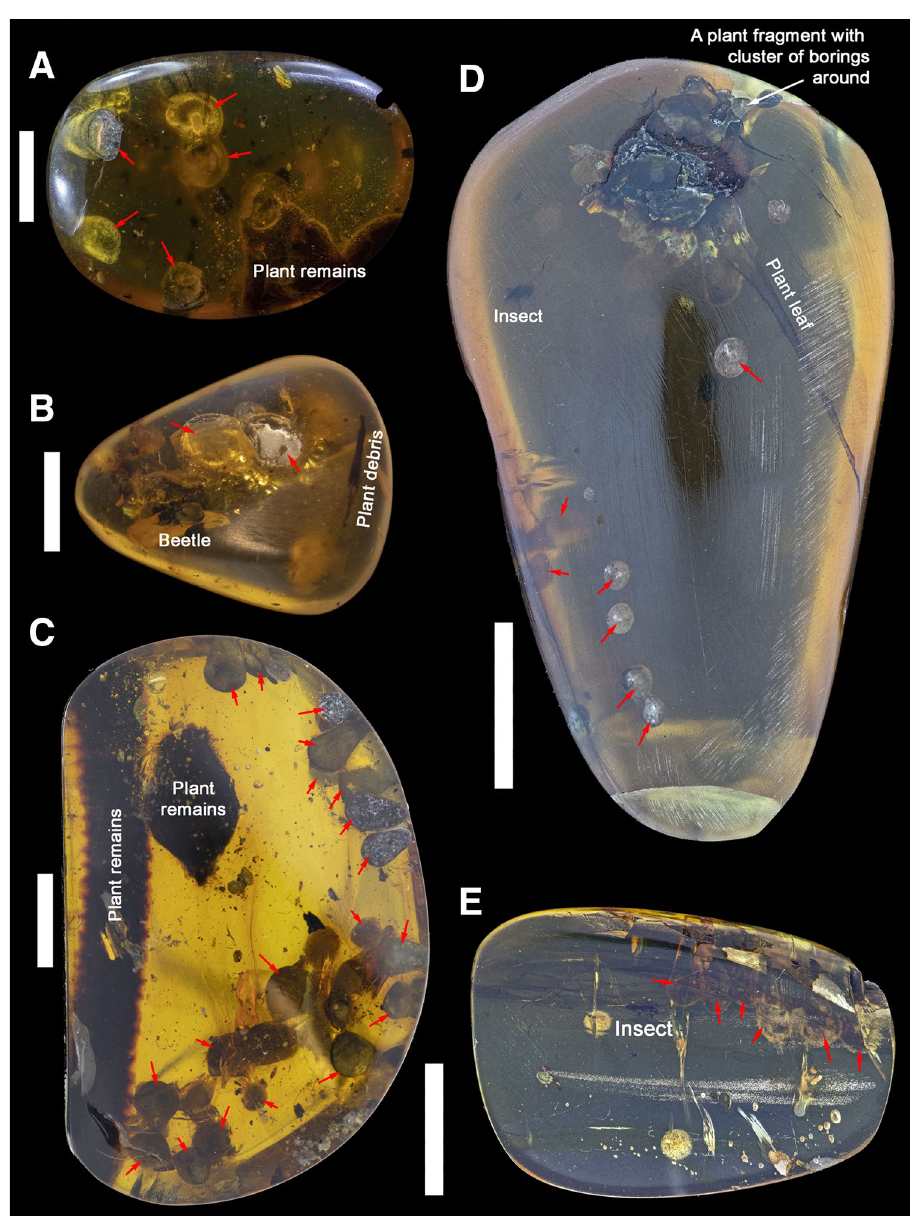
Figure 2. Lower Cenomanian Kachin amber samples with borings of † Palaeolignopholas kachinensis gen. & sp. nov. from northern Myanmar used in this study. ( A ) RMBH biv1102 (frontal view). ( B ) RMBH biv1103 (frontal view). ( C ) RMBH biv1114 (frontal view). ( D ) RMBH biv1118 (frontal view). ( E ) RMBH biv1117 (frontal view). The red arrows indicate bivalve borings. Scale bars = 5 mm. (Photos: Ilya V.